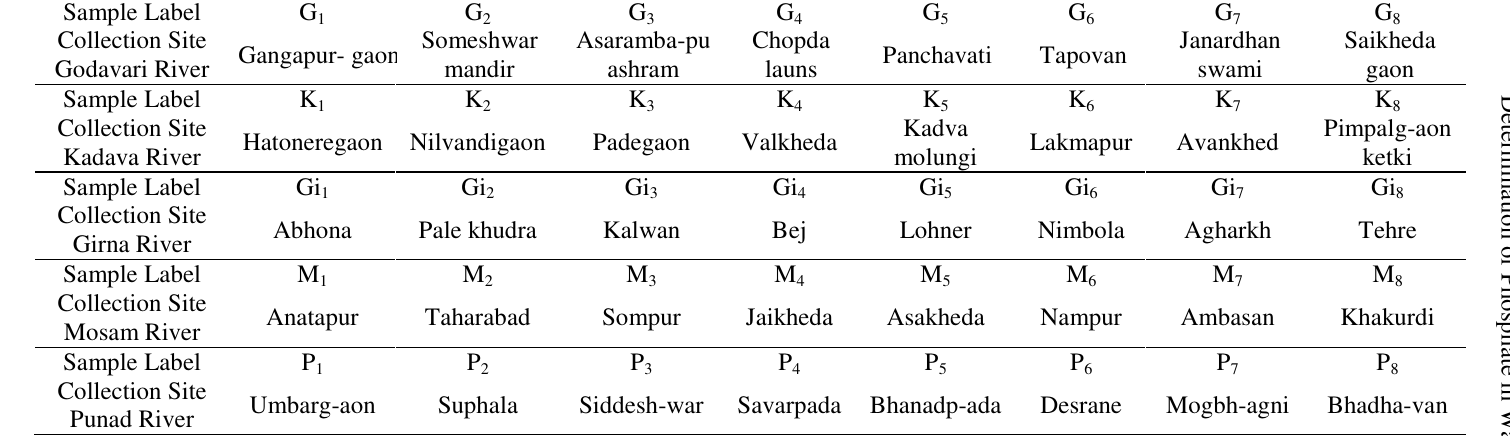
Table 1. Water Sample collection sites of various rivers of Nashik